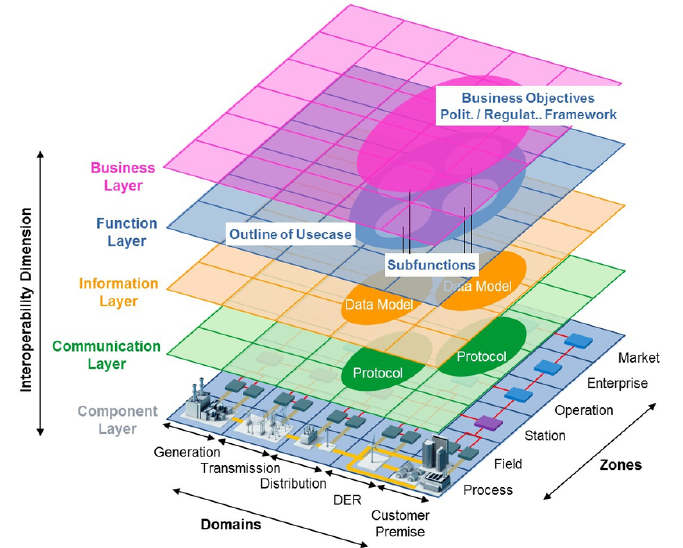
Figure 1. Smart grid architecture model (SGAM) with interoperability